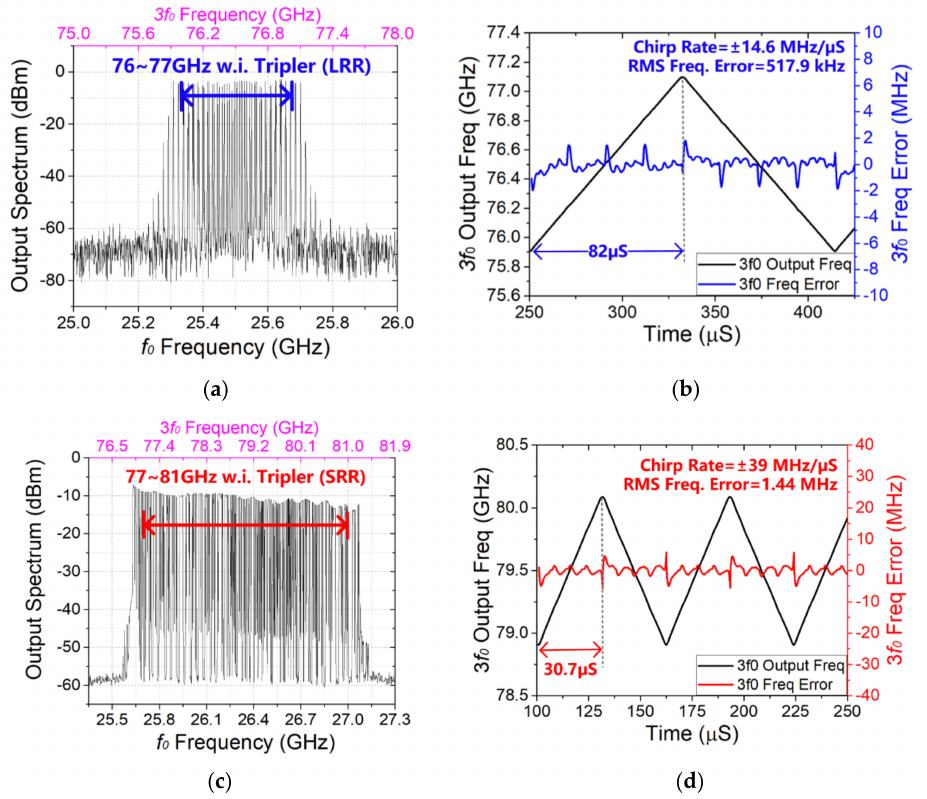
Figure 7. Measured results for the FMCW source with a triangular chirp: ( a ) the converted 3 f 0 output spectrum covering 76~77 GHz when the VCO inductor switch is at OFF-state; ( b ) the converted 3 f 0 frequency waveform and frequency error for LRR-band; ( c ) the converted 3 f 0 output spectrum covering 77~81 GHz when the VCO inductor switch is at ON-state; ( d ) the 3 f 0 frequency waveform and frequency error for